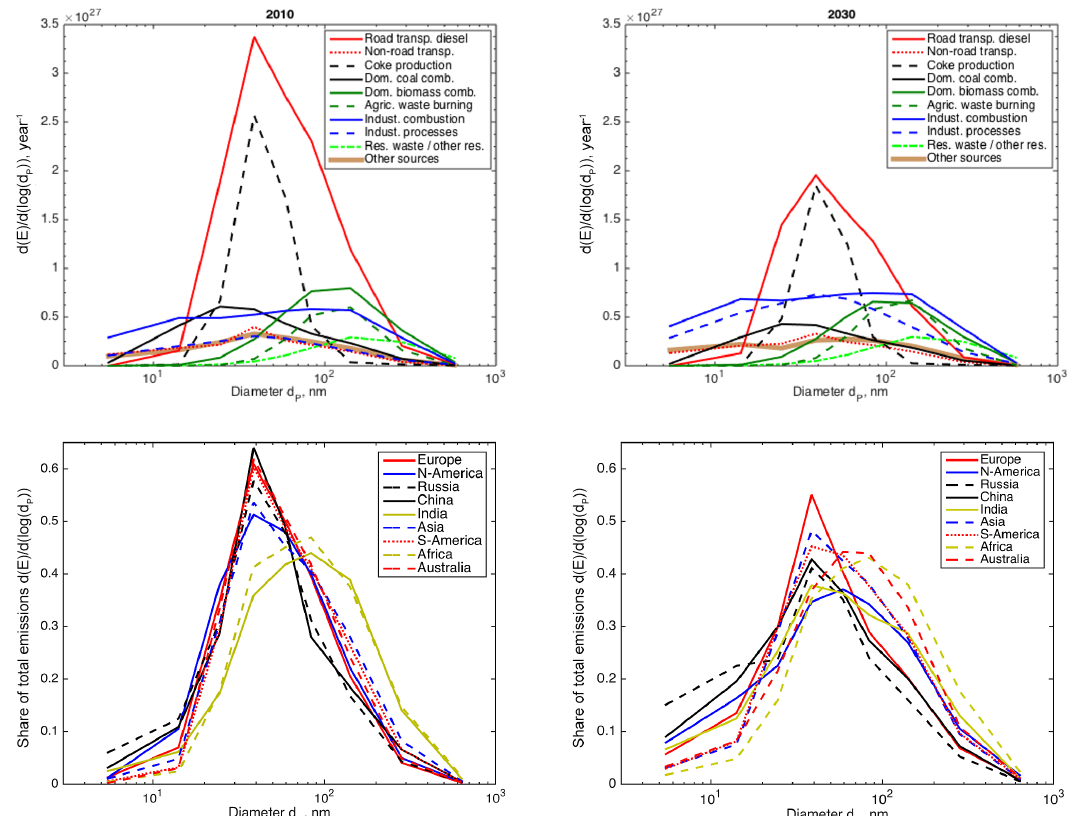
Figure 6. Particle number size distributions of the major global aerosol emission sources (upper panel) and normalized number size distri- butions for each region (lower panel). The left side figures are for 2010 and the right side ones for 2030.